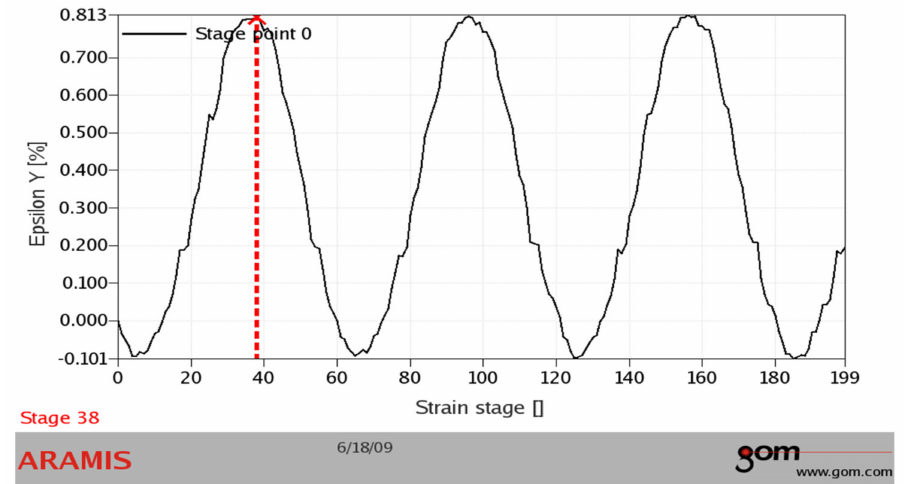
Figure 21. The distribution of the deformation value from the images.